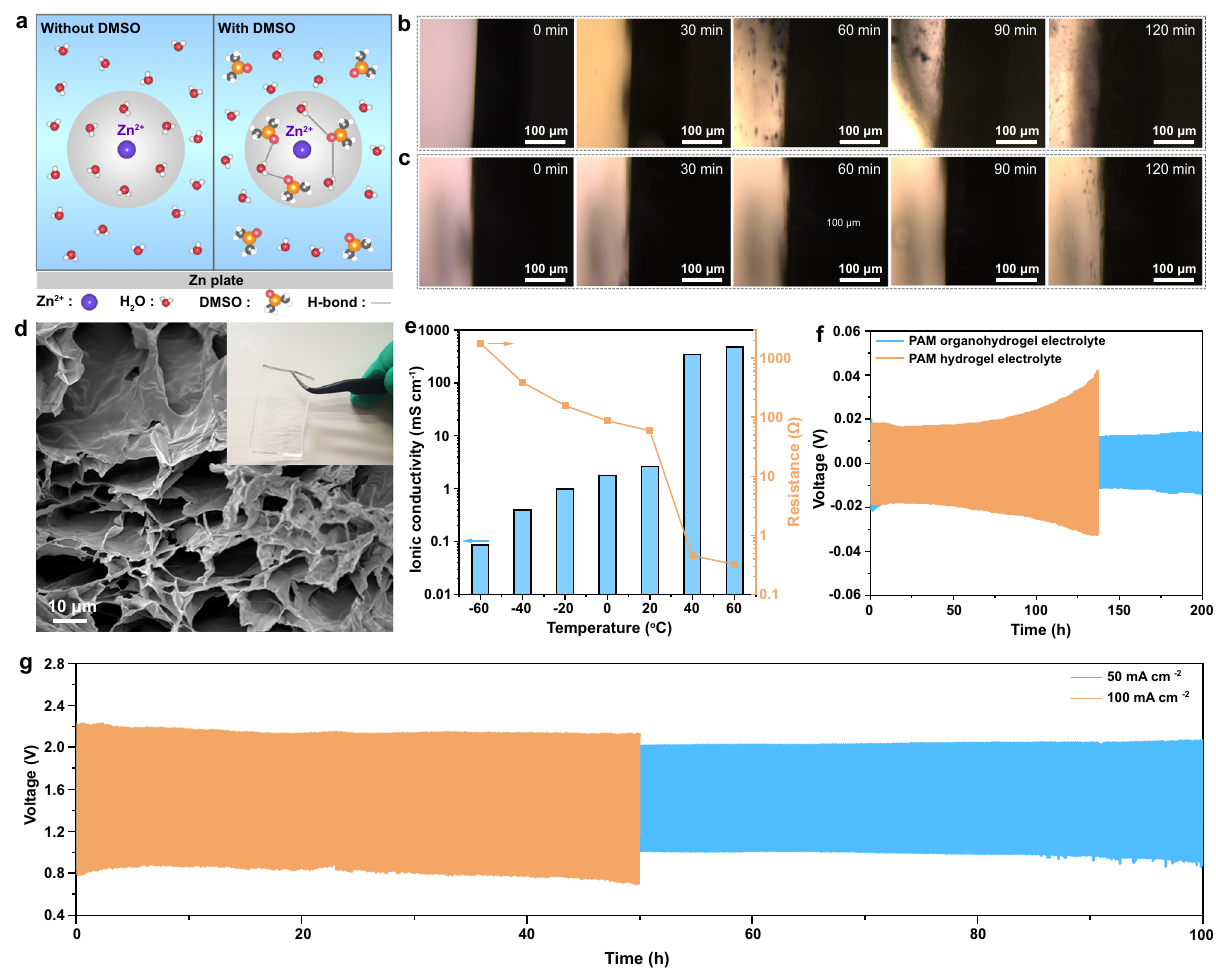
Fig. 3 The role of DMSO in aqueous electrolytes, characterizations of the organohydrogel electrolyte and electrochemical performance of the Co SA- NDGs-based quasi-sold-state ZABs. a Zn 2 + solvation structure and formed H-bond between DMSO and H 2 O molecules. The gray circles correspond to the solvation sheath structure of Zn 2 + . In situ optical visualization observation of the Zn|electrolyte interface during different operating conditions (charging/discharging cycle time of 10 min): b charging/discharging at 5 mA cm − 2 in 6 M KOH + 0.2 M Zn(Ac) 2 ; c charging/discharging at 5 mA cm − 2 in 6 M KOH + 2 M DMSO + 0.2 M Zn(Ac) 2 . d SEM image of the freeze-dried PAM organohydrogel electrolyte. Inset shows the corresponding optical photograph of PAM organohydrogel. e Ionic conductivity for PAM organohydrogel electrolyte at various operating temperatures. f Cycling performance of the symmetric Zn | |Zn cells employing PAM hydrogel electrolyte and PAM organohydrogel electrolyte at 2 mA cm − 2 . g Charging/discharging performance of quasi-solid-state ZABs with Co SA-NDGs at 50 and 100 mA cm − 2